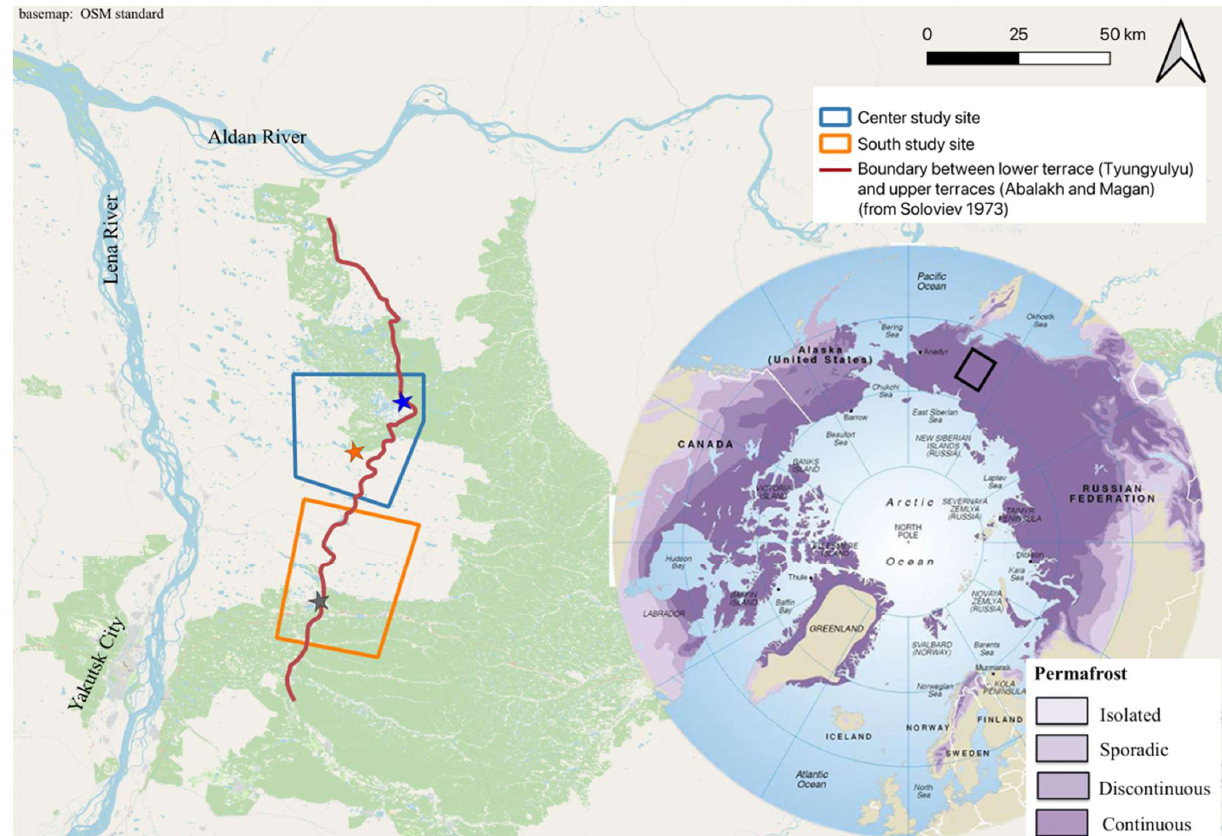
Figure 1. The general study area location is outlined by the black rectangle on the globe. The study area is located within the continuous permafrost zone of Eastern Siberia, about 120 km from the city of Yakutsk. The center study site is outlined in blue on the OSM standard basemap. In the center study site, the City of Borogontsy is indicated by the blue star and Syrdakh Village is indicated by the orange star. The south study site is outlined in orange. The City of Balyktakh is indicated by the gray star. The Lena River runs south to north. The Aldan River runs east to west. The base map is OpenStreetMap standard (the green color is ‘natural grassland’). Permafrost distribution map from [1].